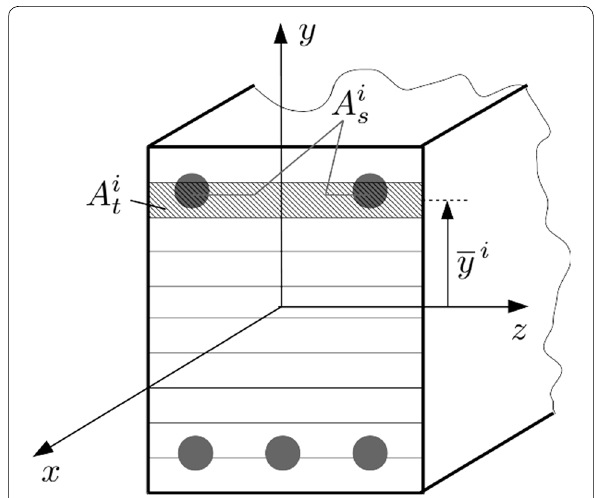
Fig. 1 Axial beam cross section discretized into layers along the beam height (stirrups are not shown) with A ti and A ti the total and the steel area in layer i ,